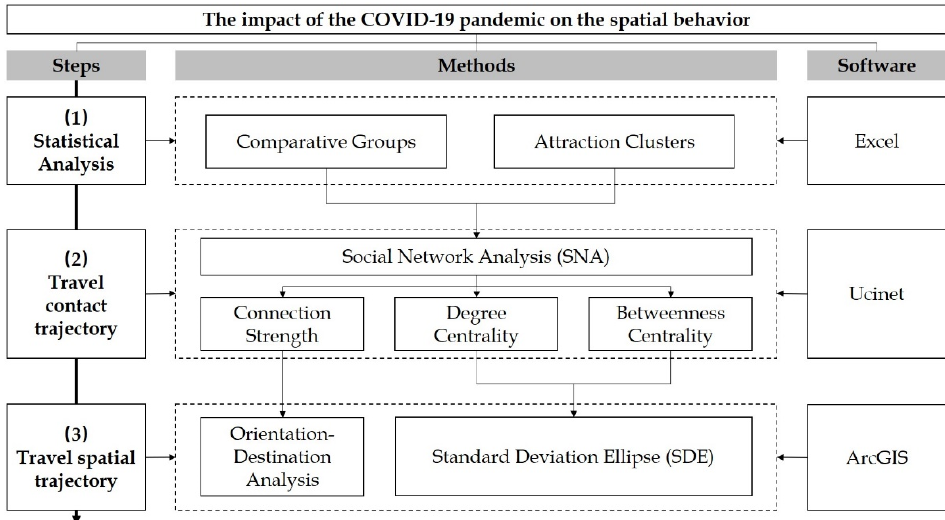
Figure 2. Research Methods and Analysis Framework.